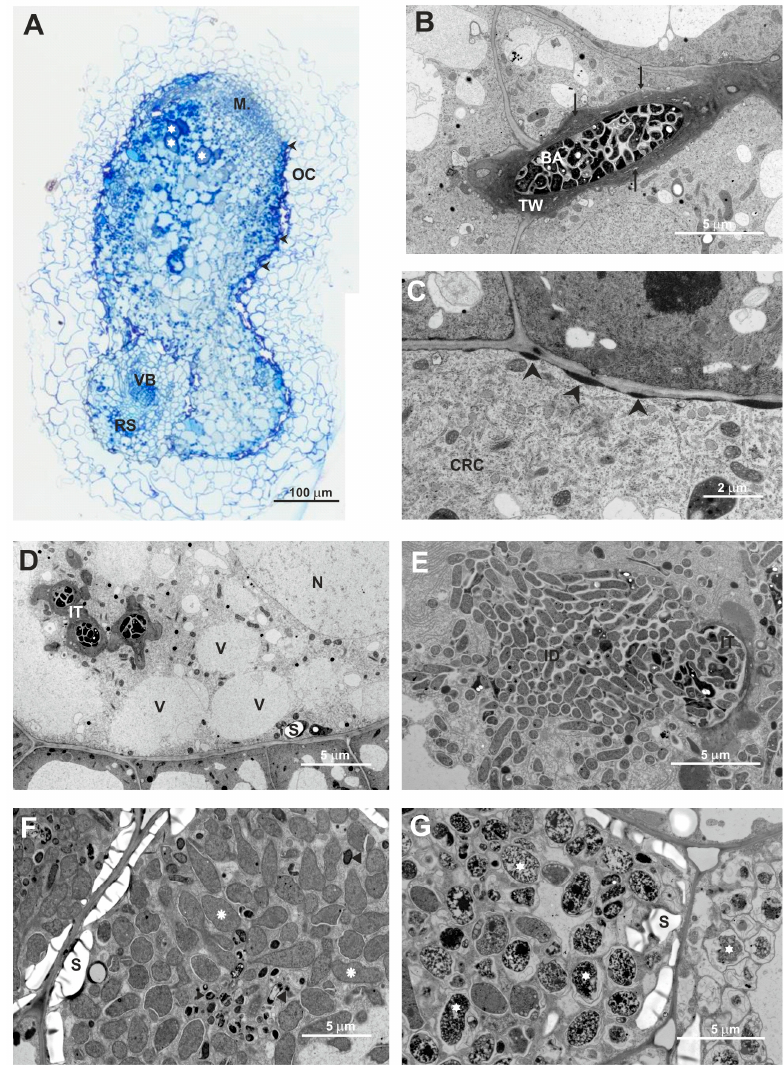
Figure 14. Semi-thin section of a 21-dpi clover root nodule elicited by the R. leguminosarum mutant Rt297 ( A ), M: meristem; OC: outer cortex; RS: root stela; VB: nodule vascular bundle; white asterisks: infected cells; arrow head: nodule endodermis. ( B ), Ultrastructure of the IT containing Rt297 cells: BA: bacteria, TW: thread wall; arrows: material deposited between osmiophilic layers of the thread wall. ( C ), Deposits of electron-dense material on the cortical root cell wall (arrow heads) (CRC: the cortical root cell). ( D ), A cortical root cell which undergoes autolysis; N: nucleus; IT: infection thread; S: starch granules; V: vacuoles. ( E ), “Explosion-like” mass endocytosis of bacteria by the plant cell cytoplasm; ID: infection droplet. ( F ), A mature infected cell; S: starch granules; rosette: abnormally differentiated bacteroids; triangle: precociously degenerated bacteroids. ( G ), an infected cell containing degrading bacteroids (stars); S: starch